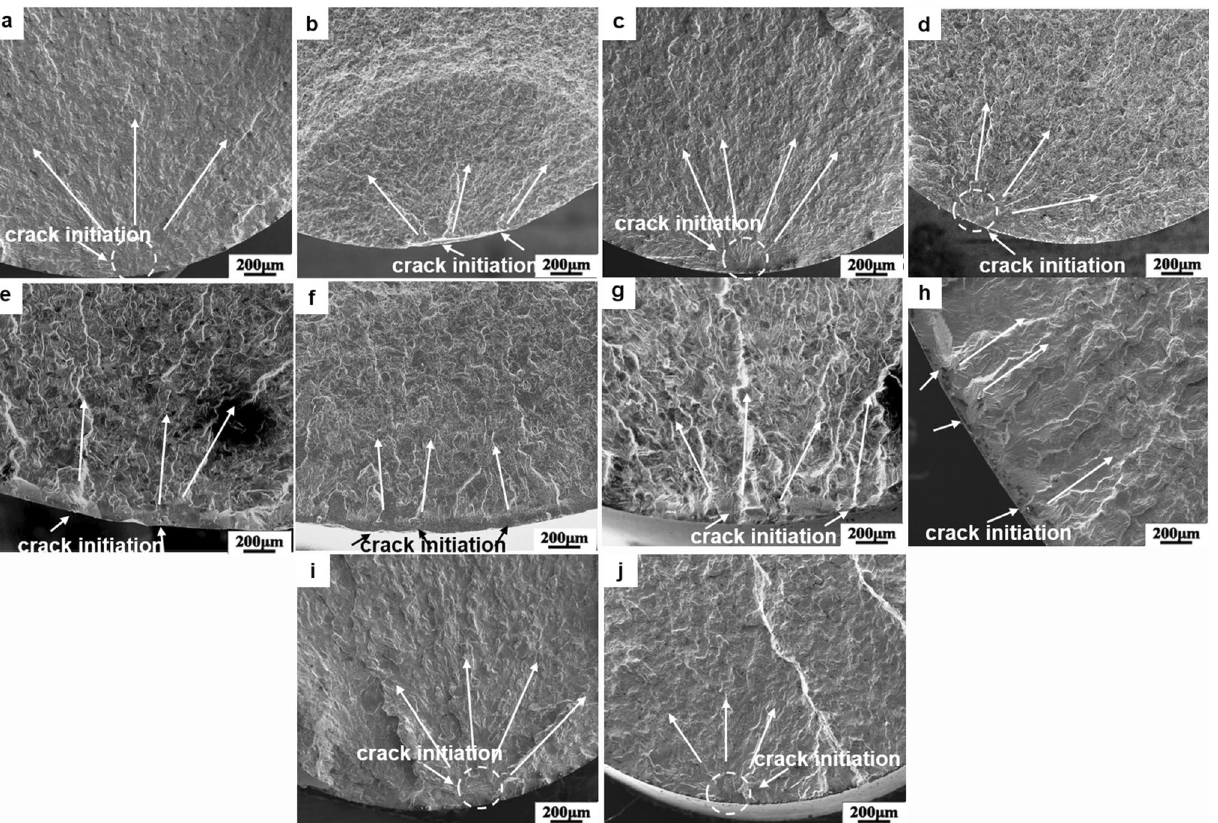
Figure 7. Fracture morphologies of different treated samples: ( a , b ) AN series at strain amplitude of 0.5%, 0.8%, respectively; ( c , d ) USDR series at strain amplitude of 0.5%, 0.8%, respectively; ( e , f ) USDR-OBD series at strain amplitude of 0.4%, 0.8%, respectively; ( g , h ) OBD series at strain amplitude of 0.4%, 0.8%, respectively; ( i , j ) R series at strain amplitude of 0.5%, 0.8%,